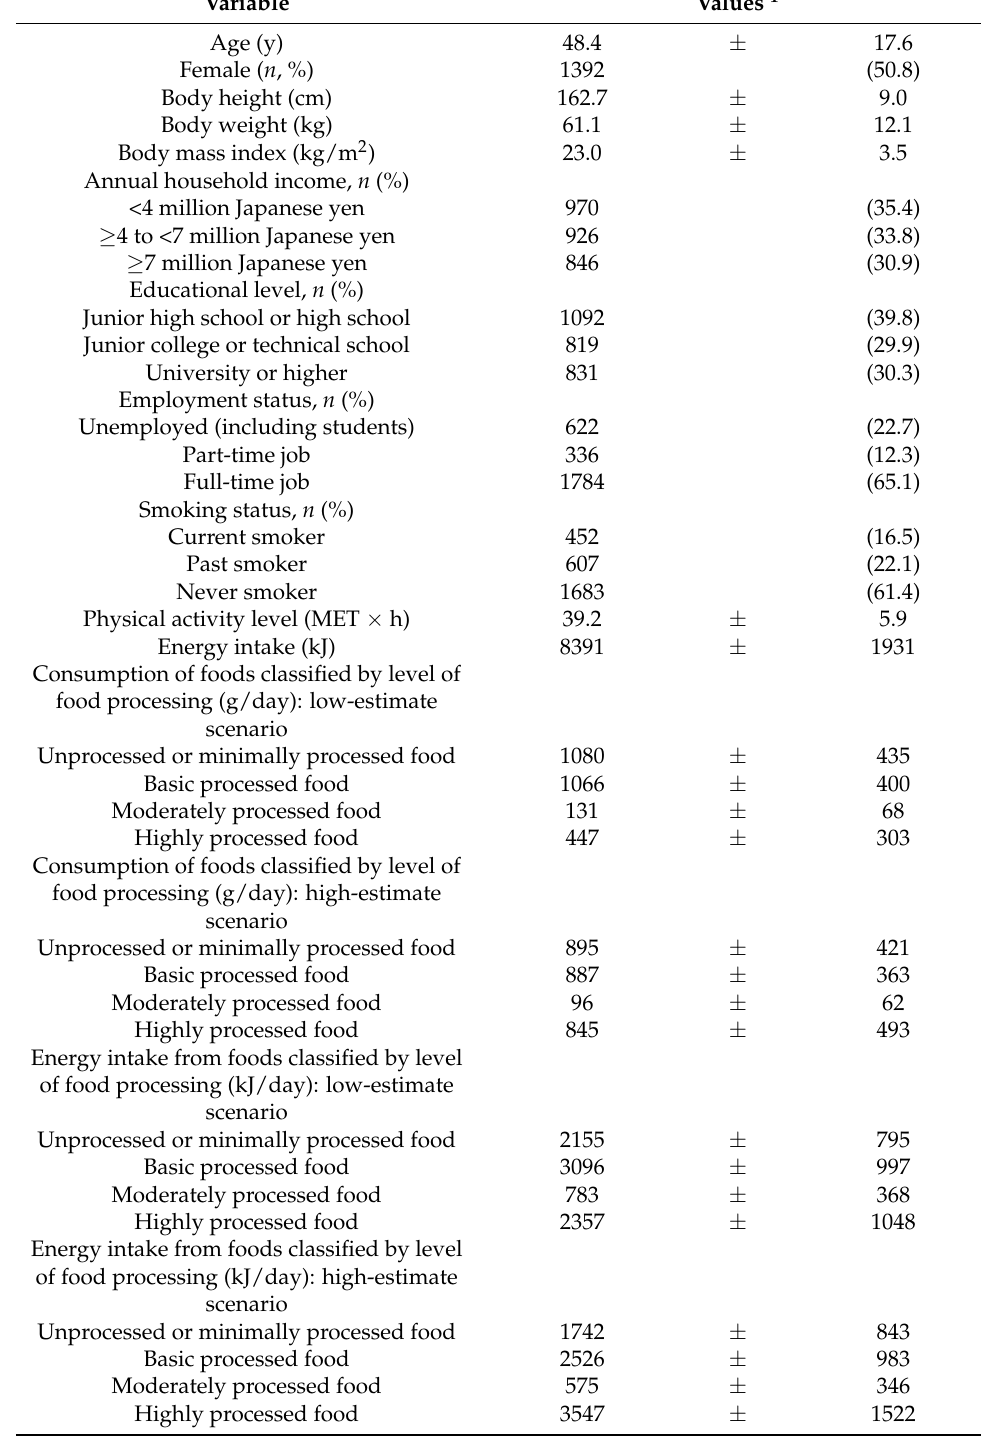
Table 1. Basic characteristics of the study participants ( n =